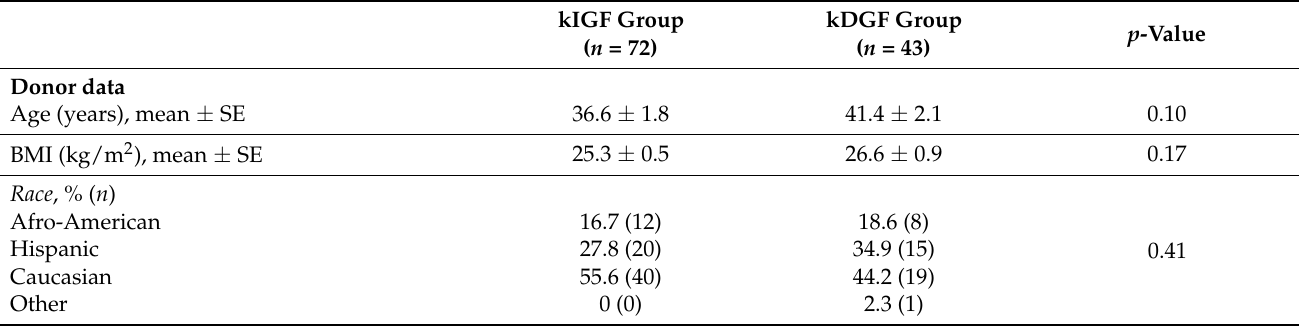
Table 2. Comparisons of preoperative donor/HPMP variables by group (kIGF vs. kDGF) 1